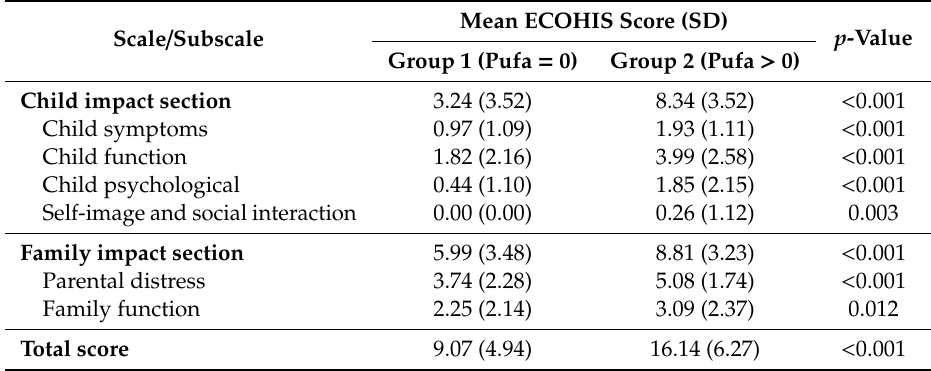
Comparative analysis of QoL between children with and without pulpo-periapical complications. (Independent t -test, statistically significant at p -value < 0.001). Mean ECOHIS Score (SD) p -Value Scale / Subscale Group 1 (Pufa = 0)